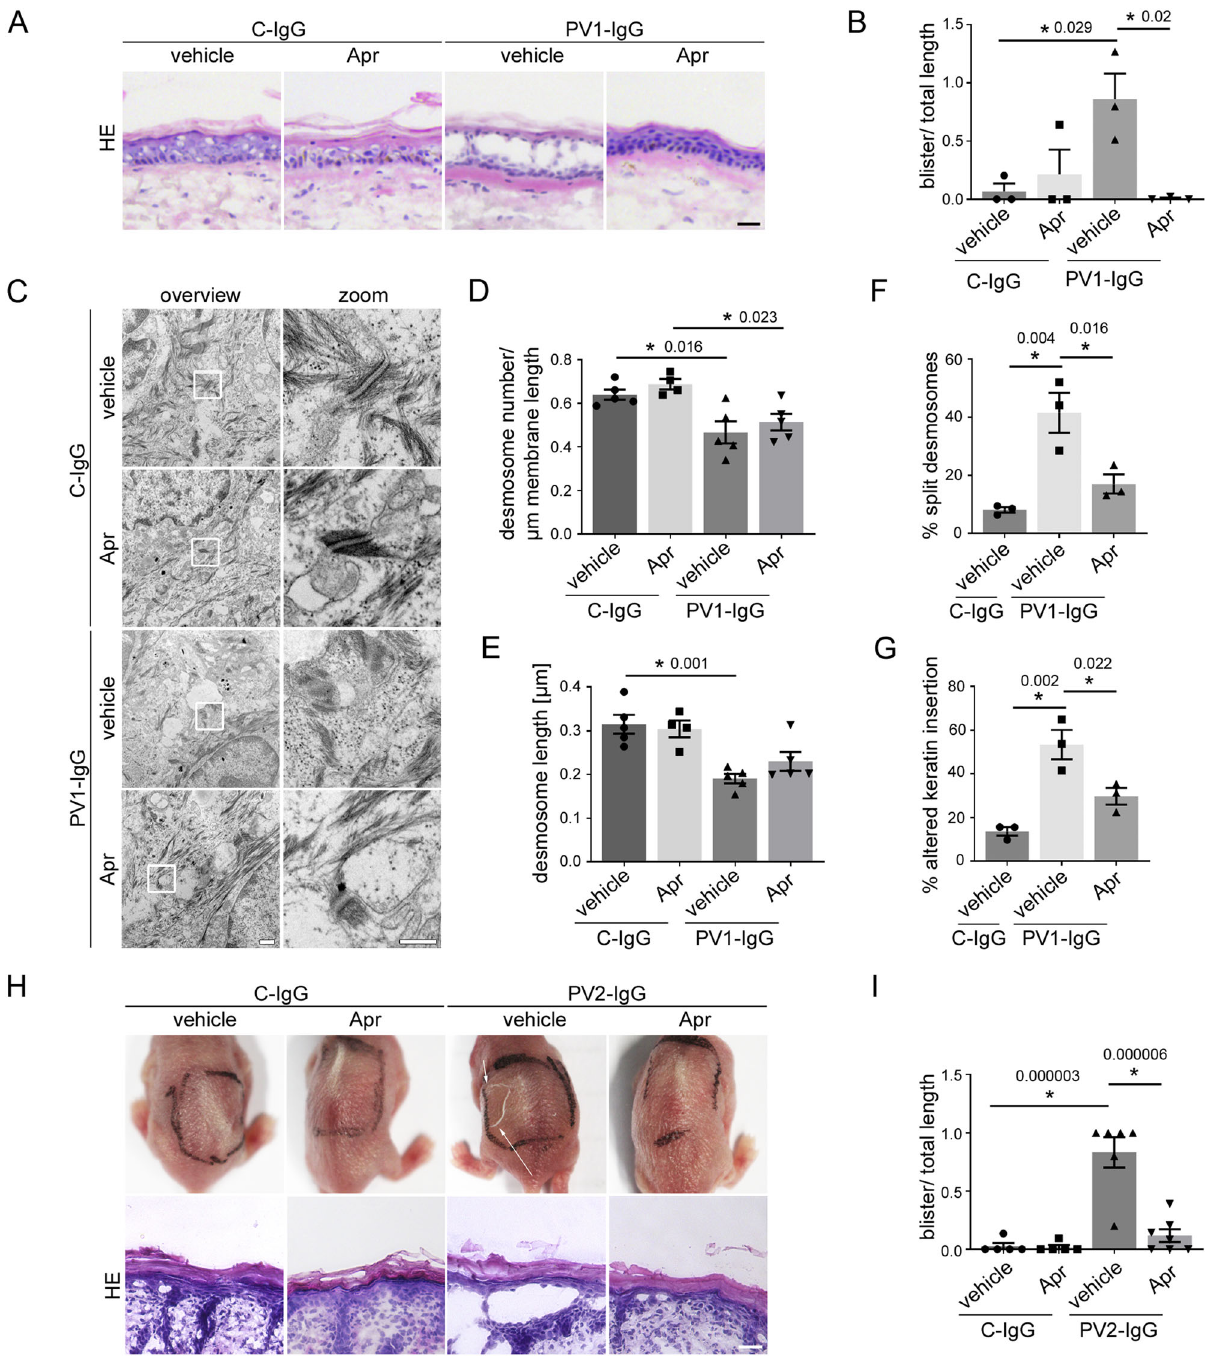
Fig.1|Apremilastisprotectiveinanexvivopemphigusskinmodelandinvivo in a neonatal pemphigus mouse model. A HE staining of human ex vivo skin samples from healthy humans after injection of vehicle (DMSO) or apremilast (Apr) prior to injection of PV1-IgG or control (C)-IgG. Apremilast (100 µ M) pre- vented PV1-IgG-induced intraepidermal blister formation. Scale bar=25 µ m. Representative of n =3. B Quanti fi cation of blister length revealed a signi fi cant decrease in blister length after apremilast treatment ( n =3). C Electron micro- scopic analysis of desmosome ultrastructure of ex vivo skin samples. Scale bar (overview)=500nm. Zoom in areas marked with white rectangles. Scale bar (zoom)=200nm. Representative of n =5. Quanti fi cation revealed no rescue of PV1-IgG-induced reduction in number ( D , n =5) and length ( E , n =5) of